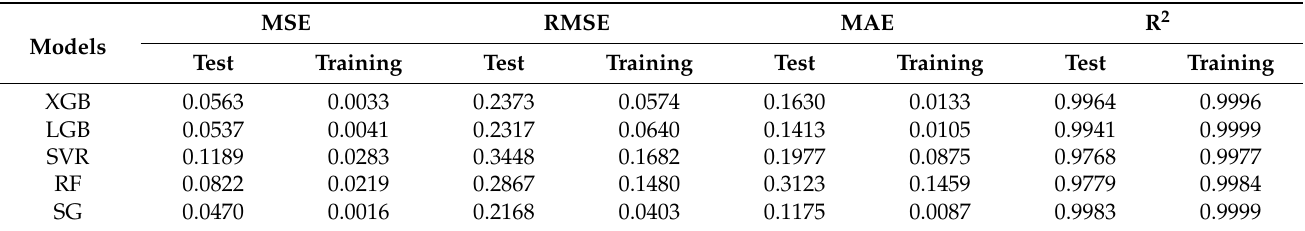
Table 7. Prediction performance evaluation results of each